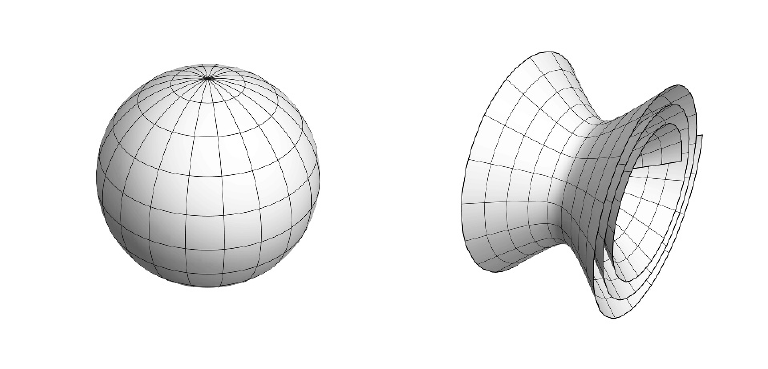
Figure 1 . Images of a sphere and of a universal cover of AdS